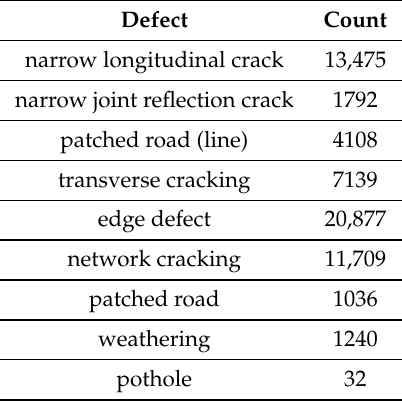
Table 5. Distribution of defect